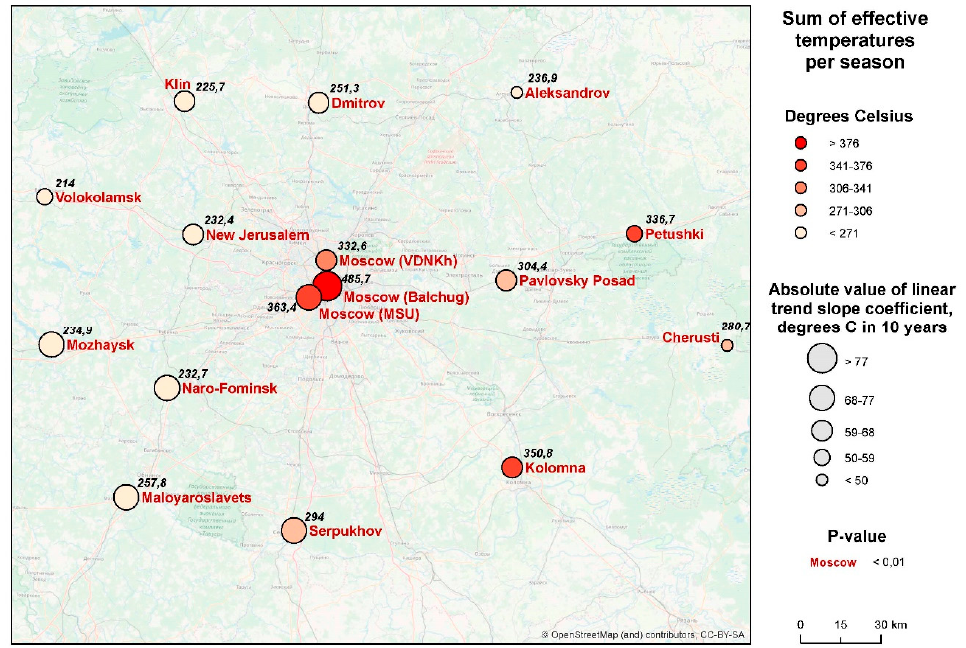
Figure 6. Spatial distribution of changes in the sum of effective temperatures in the Moscow region in 1977–2016 (figures for each station indicate the average amount of effective temperature, or ET, for the period).